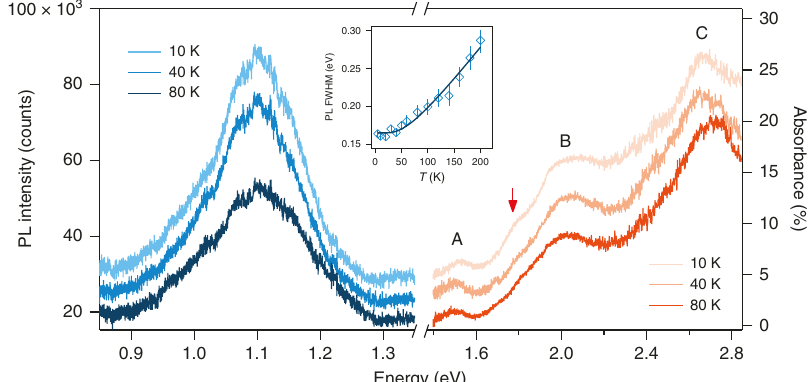
Fig. 1 Exciton transitions in bilayer CrI 3 . Photoluminescence (PL) (left, blue) and absorption (right, orange) spectra of a bilayer CrI 3 encapsulated between two hBN fl akes and placed on the sapphire substrate, at 10, 40, and 80 K. A, B, and C denote three main exciton transitions at 1.51, 1.96, and 2.68 eV, and the orange arrow marks a shoulder mode at 1.79 eV appearing only at low temperatures. Spectra at 10 K and 40 K are offset vertically for clarity. Inset shows the fi tted full width at half maximum (FWHM) of PL spectra as a function of temperature, Γ T ð Þ , (diamond symbols) and its fi tting to the functional (cid:1) (cid:3) form Γ T ð Þ ¼ Γ 0 þ γ with the fi rst and second terms for impurity-related inhomogeneous broadening and e-ph coupling-induced homogeneous (cid:2) 1 exp (cid:1) h ω LO kBT broadening, respectively. Error bars indicate one standard error in fi tting the FWHM of PL